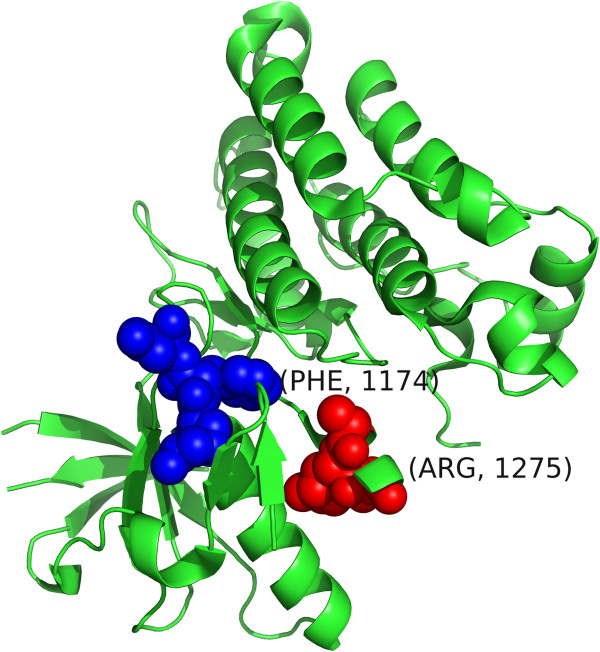
ALK clustering. The ALK structure (PDB ID: 2XBA) where cluster 1173-1175 is shown in blue and cluster 1274-1276 is shown in red. The central residue in each cluster (1174 and 1275 for the blue and red clusters respectively) is labeled.